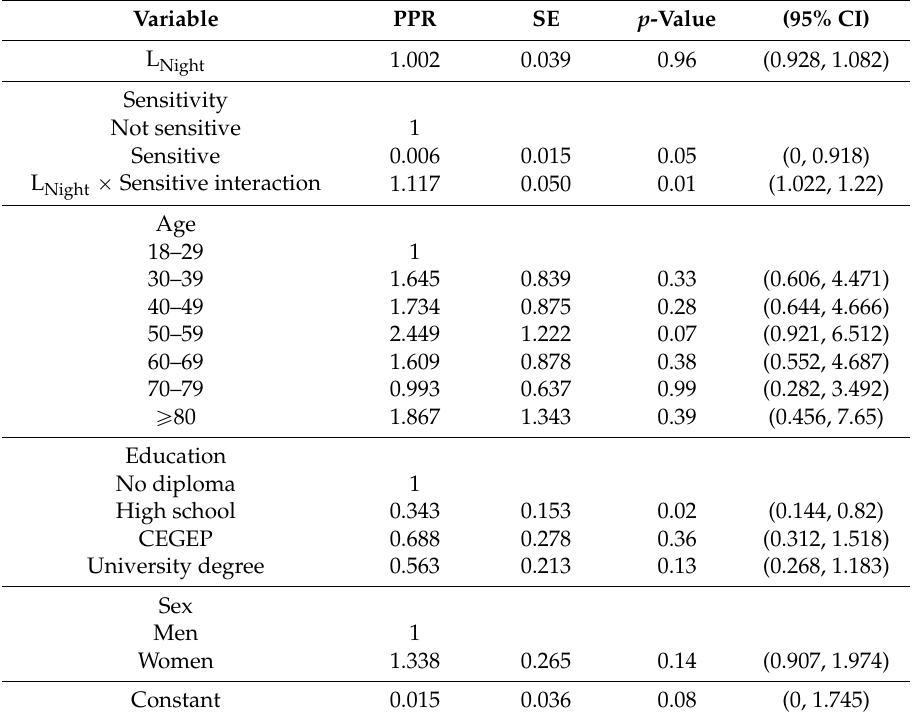
Table A14. L Night and marginal proportions of sleep disturbance by road noise in the weighted study sample, adjusted for sensitivity to noise: regression.